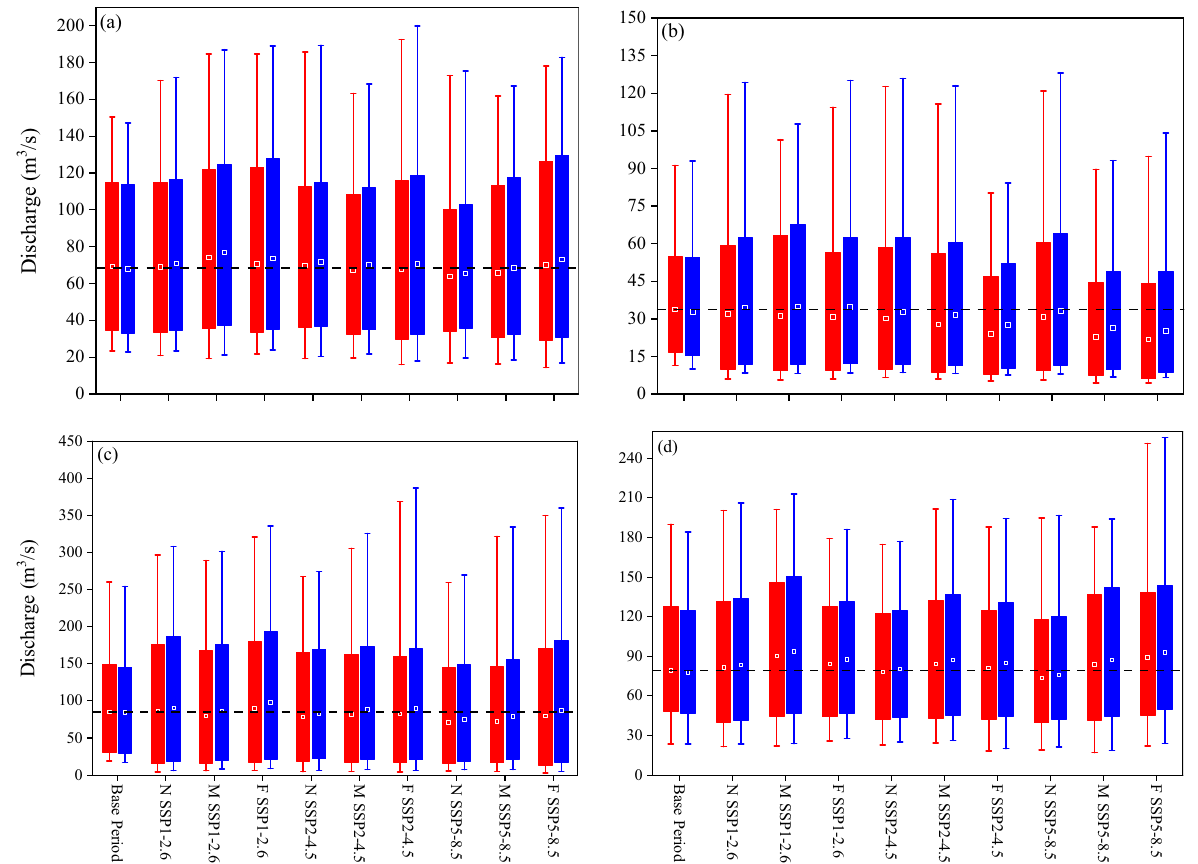
Figure 7. Box plot of the seasonal streamflow under multi-GCMs and land use land cover (LULC) changes for different scenarios to compare the variation among base period (1989–2020), near future (2021–2050), mid future (2051–2080), and far future (2081–2100) in ( a ) spring, ( b ) summer, ( c ) fall, and ( d ) winter. N: near future, M: mid future, and F: far future. Red box: climate change and blue box: climate and LULC changes. Dashed line indicates the average streamflow to the Anzali wetland during the base period (This figure was created in the Python 3.9 and the Jupyter notebook programming